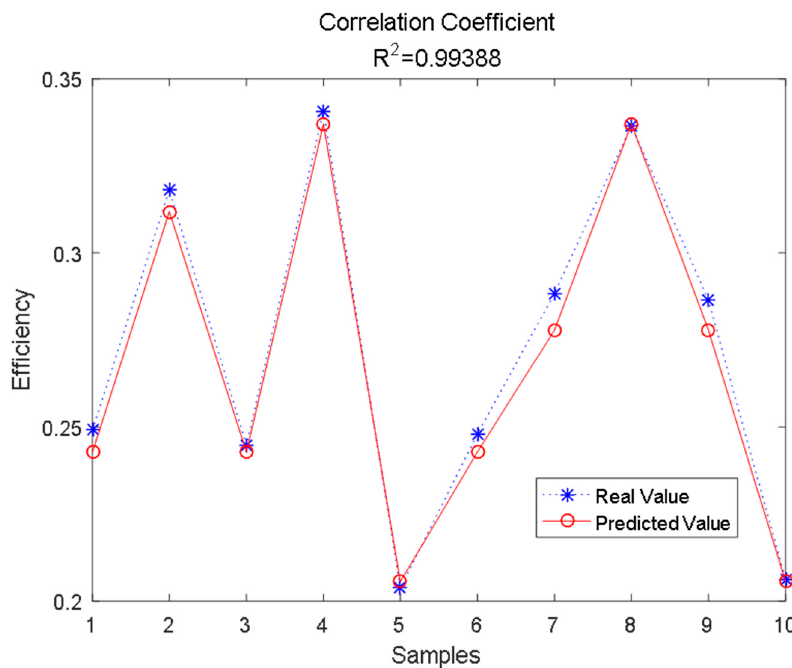
Figure 12. Efficiency predicted value by BP with learning rate optimization ( η = 0.01).